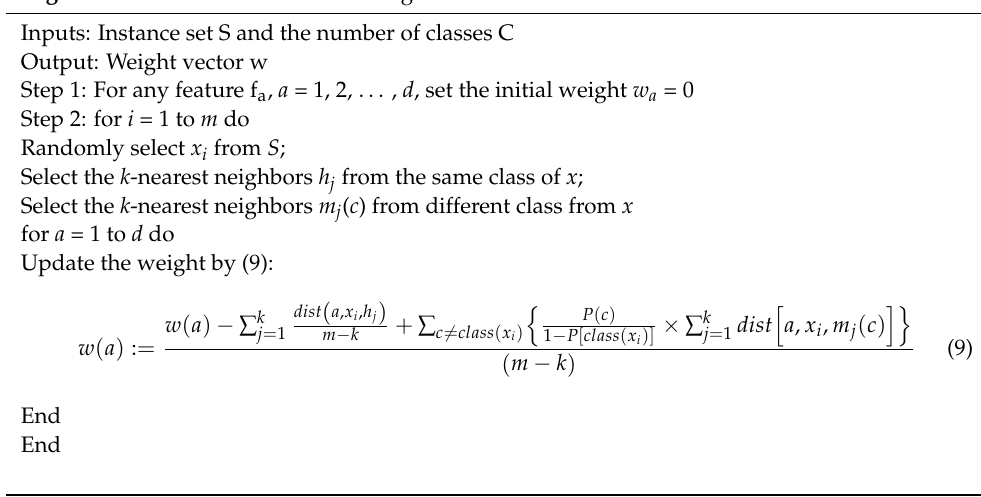
Algorithm 1. Pseudocode of ReliefF